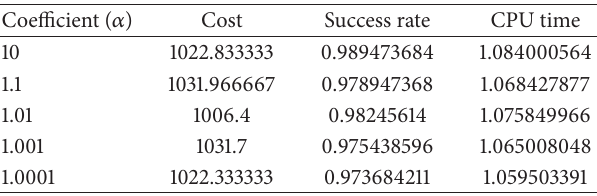
Table 3: The results obtained by different penalty coefficients ( 𝛼 ) when 𝜌 = 6